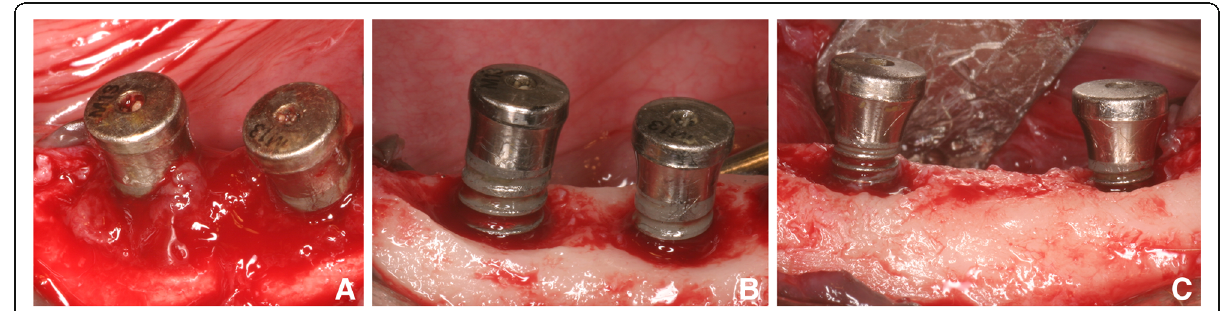
Fig. 2 Clinical views. a Standard implants with granulation tissue in the marginal sites. b Standard implants after treatment. c Narrow diameter implant sites at the